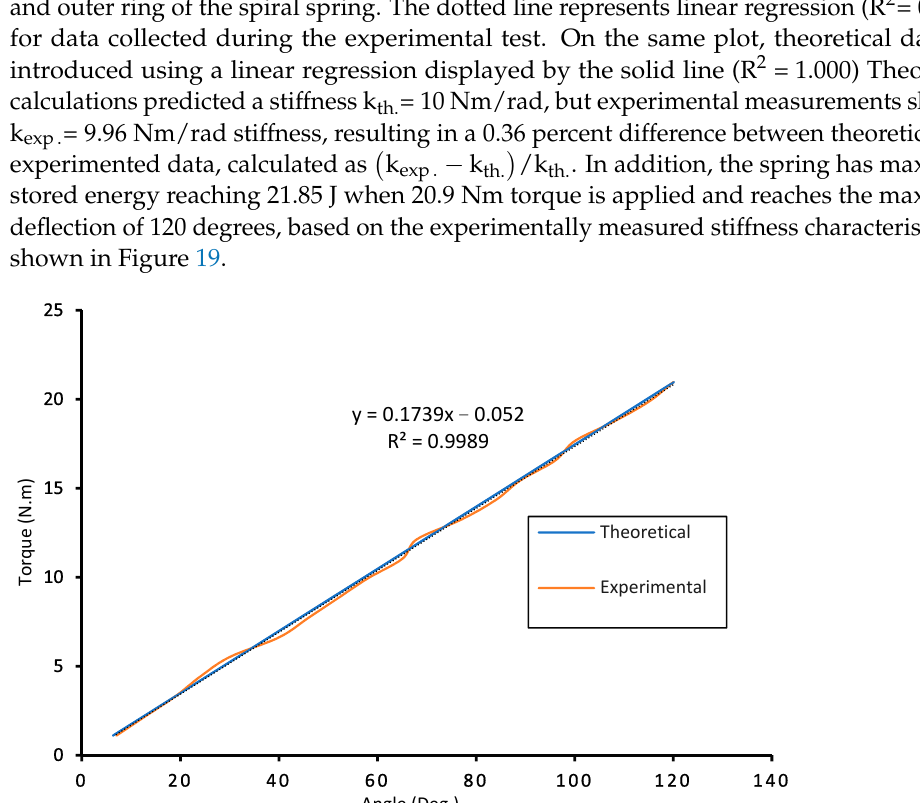
Figure 19. Energy storage Characteristic of spiral spring. The results showed that the entire design of ES ‐ RSEA for the lumbar support exo ‐ skeleton provides the maximum output torque assistance, reaching 20.9 Nm during the descent phase and 66.6 Nm during the ascent phase, as shown in Table 4. During the as ‐ cent phase, the overall output torque is combined with the DC motor’s peak output torque (45.7 Nm) and the output torque of the stored energy device (20.9 Nm). The DC motor is only turned on during the ascent phase, while it is turned off in the descent phase. How ‐ ever, this proposed strategy is advantageous in term of increasing the battery life and re ‐ ducing battery size because it satisfies the function of the motor in a single stage.